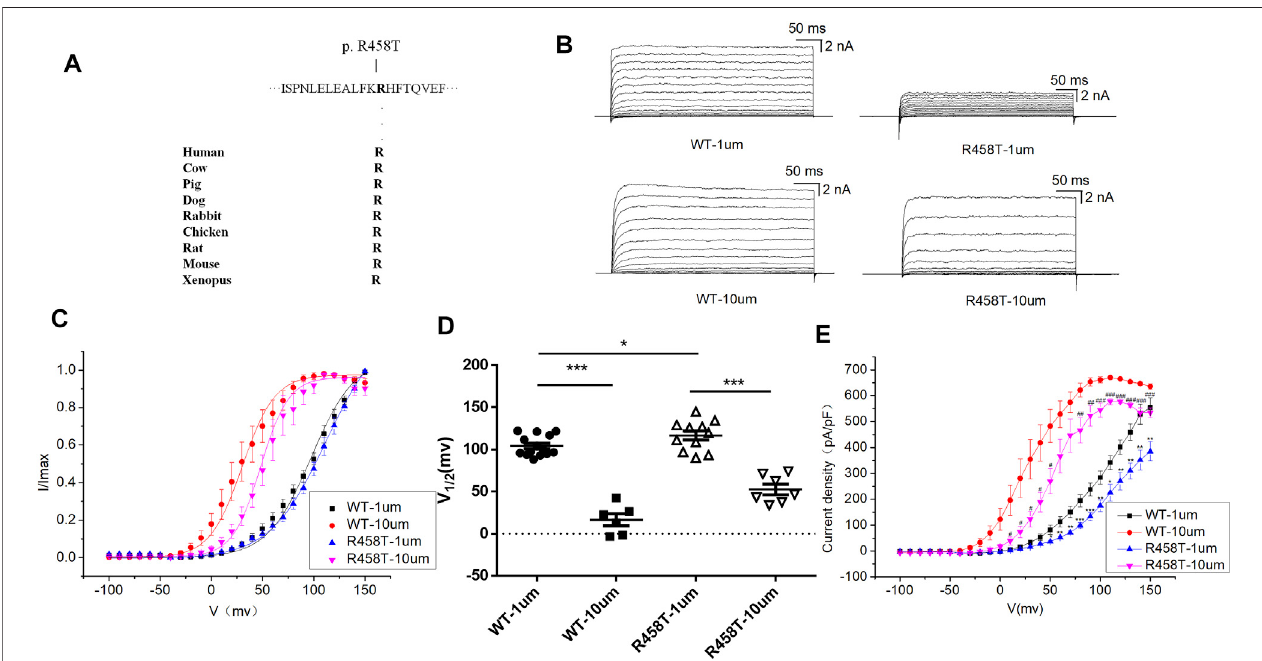
FIGURE 3 | Electrophysiological characterization of variant R458T. (A) The R458T variant occur at an evolutionarily conserved amino acid residues. (B) Representative macroscopic currents of WT and mutant BK channels with variant R458T from whole-cell patch experiments in the presence of 1 and 10 μ m Ca 2+ . (C) The I-V curves of WT and R458T mutant BK channels are shown at 1 and 10 μ m Ca 2+ . The I-V curves are fi tted by Boltzmann function (solid lines) with V1/2 and slope factor at nominal at 1 μ m Ca 2+ [97.5 ± 4.1 mV, 21.4 ± 2.1 WT, and 111.9 ± 6.3 mV, 27.5 ± 2.4 p.(R458T)] and at 10 μ m Ca 2+ [30.4 ± 2.4 mV, 15.9 ± 0.8 WT,